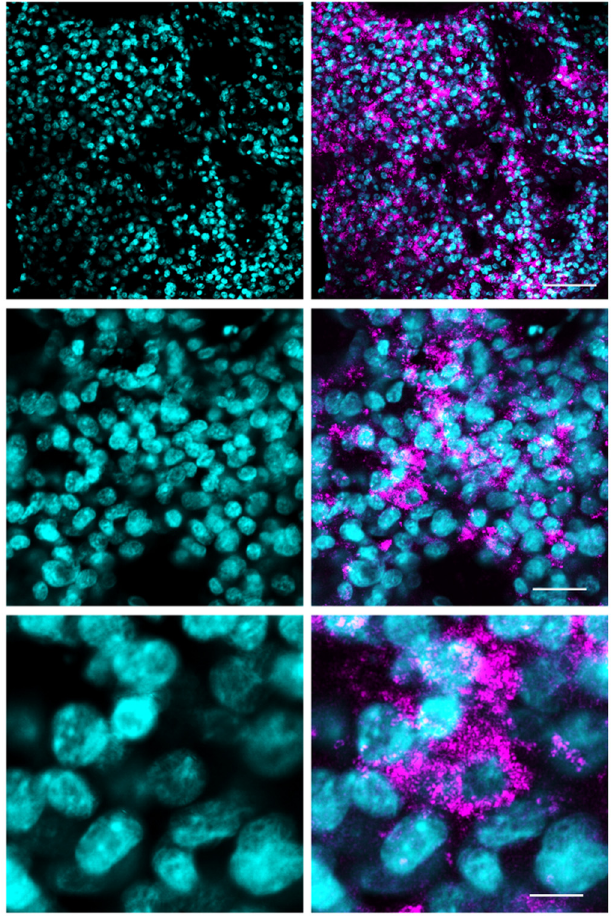
Figure 1. Fluorescence microscopy of a 5-ALA fluorescent GBM tumor (Case #16 on Table 1). Frozen sections counterstained with DAPI. Scale bars, 70 μ m (upper panels), 25 μ m (middle panels), and 10 μ m (lower panels). Objective lens, Olympus UPlanSAPO 40×/0.95 Oil.